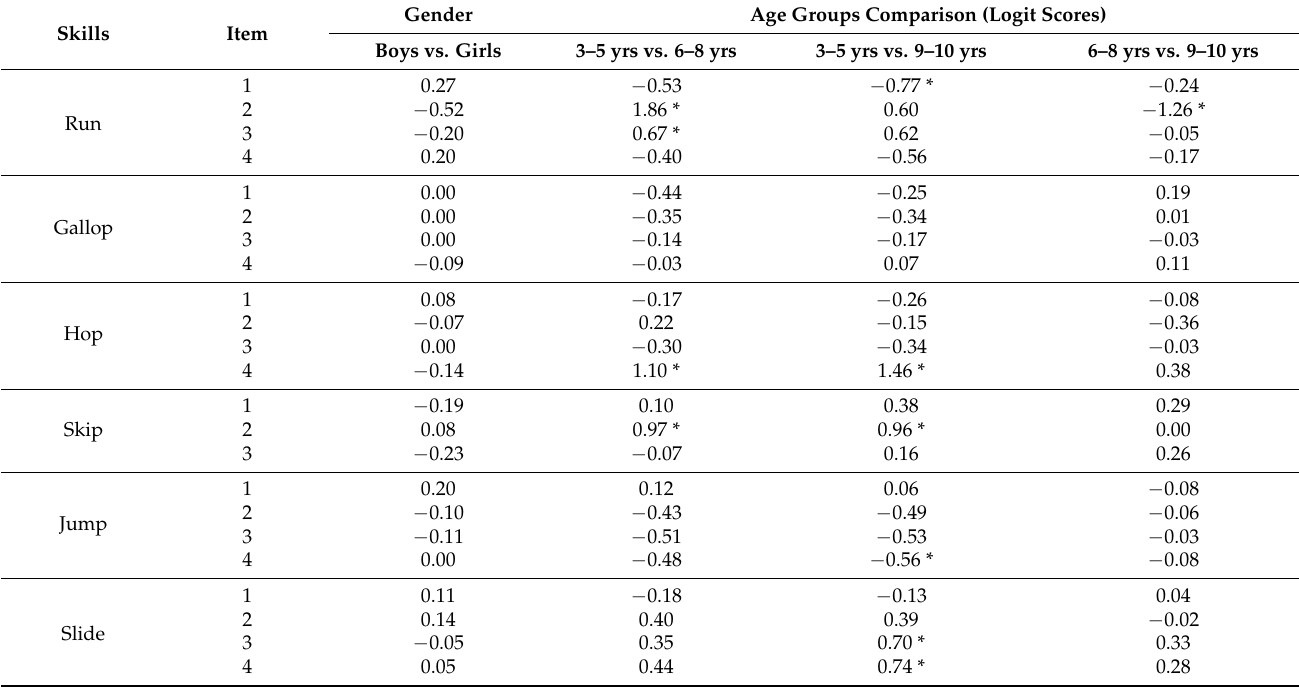
Table 4. Differential Item Functioning (DIF) of locomotor items according to gender and age group.